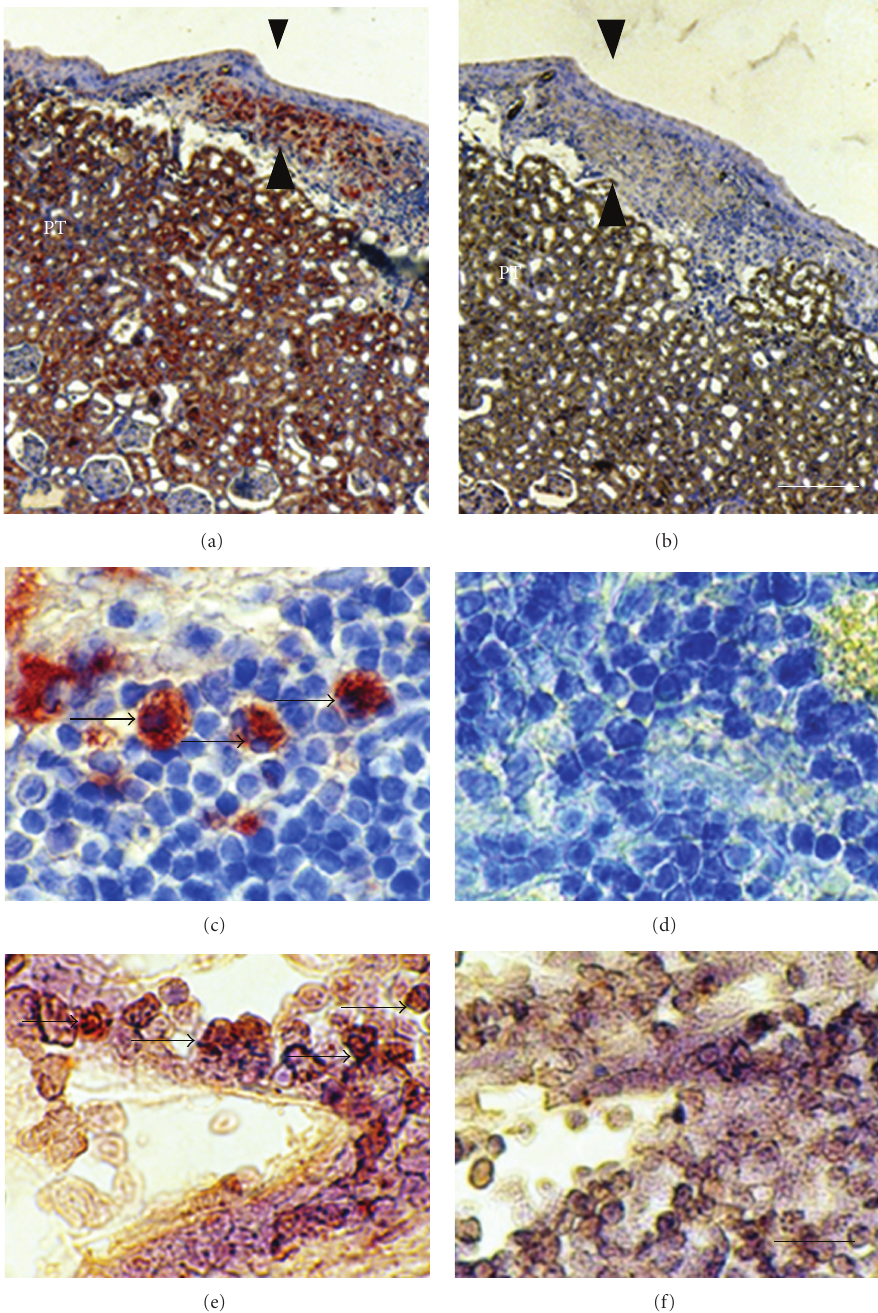
Figure 5: Photomicrographs of kidney from a diabetic rat into which embryonic pig pancreas had been transplanted in mesentery, and pig islets had been transplanted subsequently in kidney stained using anti-insulin antibody (a, c) or control antibody (b, d) and sections hybridized to antisense (e) or sense (f) porcine proinsulin mRNA probes. Arrowheads delineate an expanded subcapsular space (a, b). Arrows delineate tissue in the subcapsular space that stains positive for insulin (red-brown) (c) or positive staining for porcine proinsulin mRNA (e). PT, proximal tubule (a, b). Scale bars 80um (a, b) and 10um (c–f), reproduced with permission from the American Society for Investigative Pathology